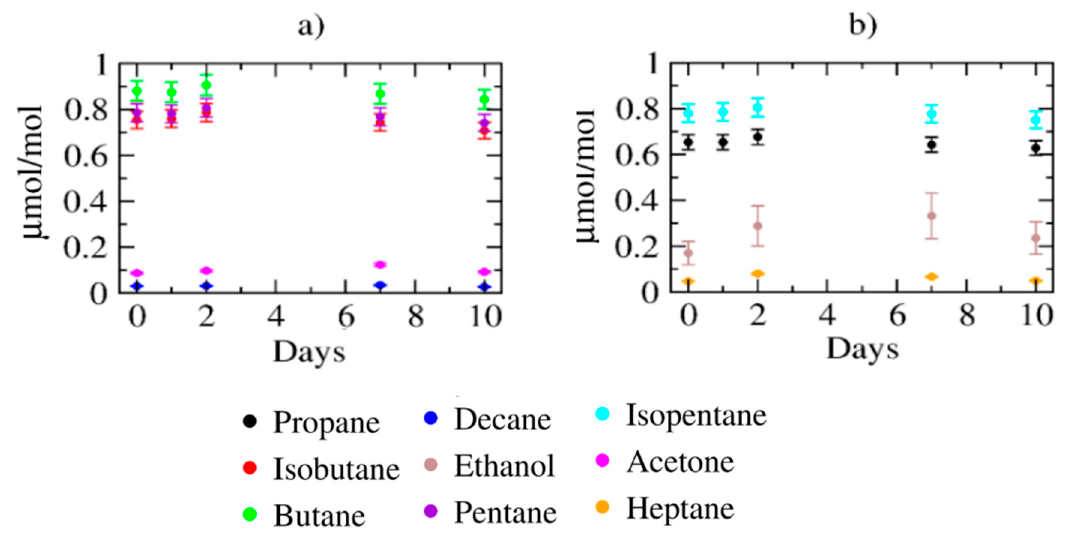
decane, ethanol; ( b ) for pentane, isopentane, acetone and heptane. Figure 1. Storage stability of hydrocarbons on Chromosorb 106.